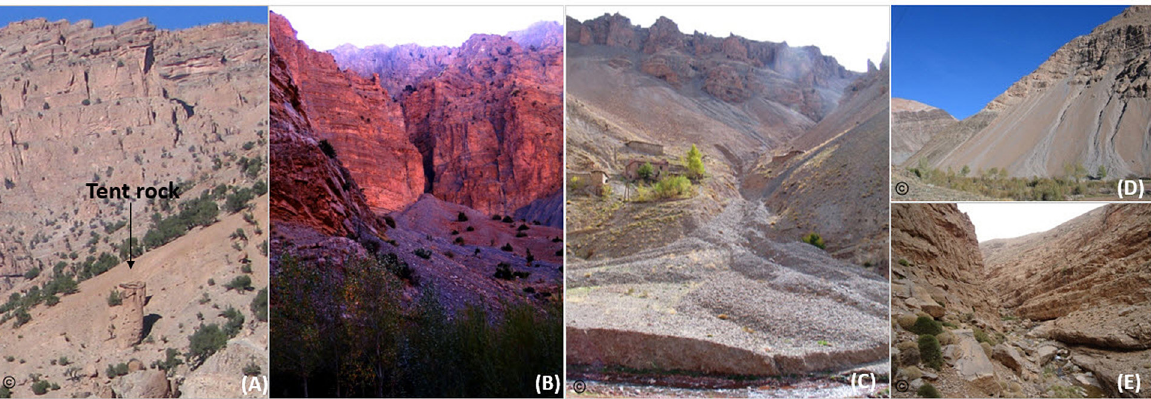
Fig. 11. The most notable geosites of the third geotouristic itinerary. A) tent rock in Tlat-n-Tazart, B) scree cone in Tlat-n-Tazart, C) alluvial fan in Ichebaken, D) scree slopes in Amezri, E) canyons of High-Tessaout